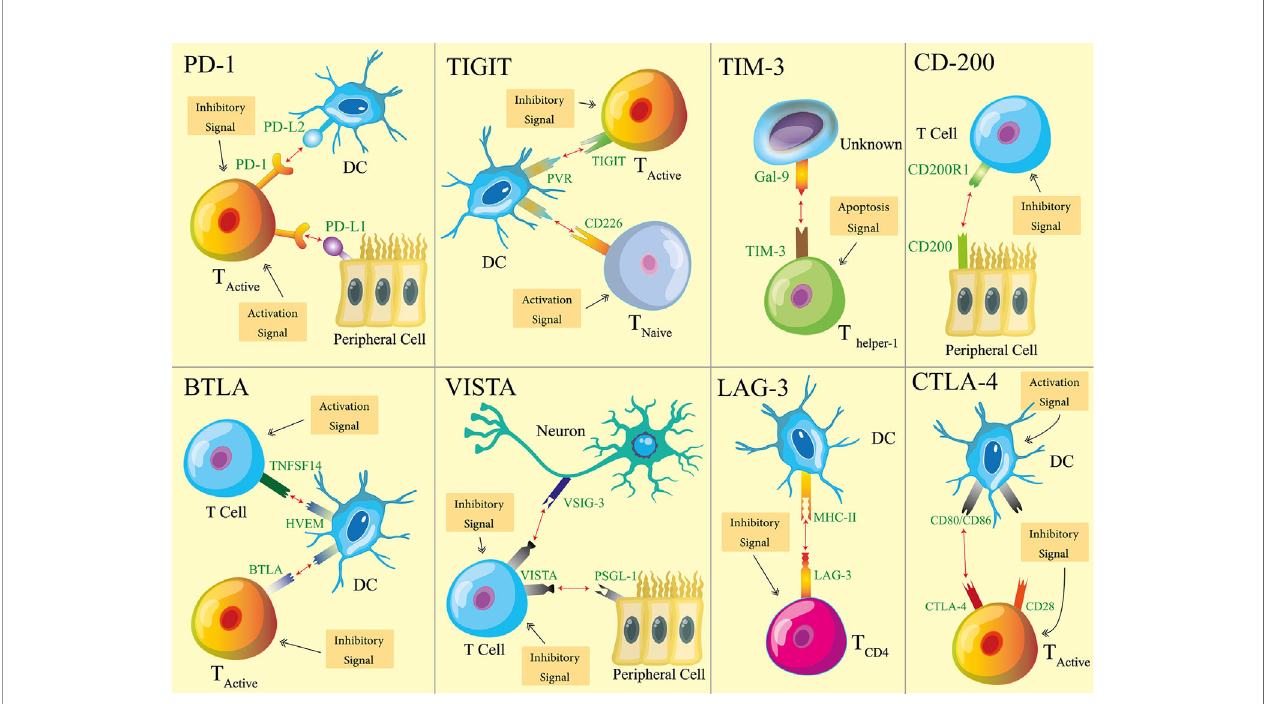
FIGURE 1 | Schematics of eight immune checkpoints (ICPs). For each ICP, one type of cells is used as the representatives that host ICP receptors or ligands. The main immune activation and inhibition implications of ICPs are illustrated with the representative cell types. It is noteworthy that the receptors and ligands may be expressed by additional cell types. The functional implications of ICPs are not limited to what are illustrated